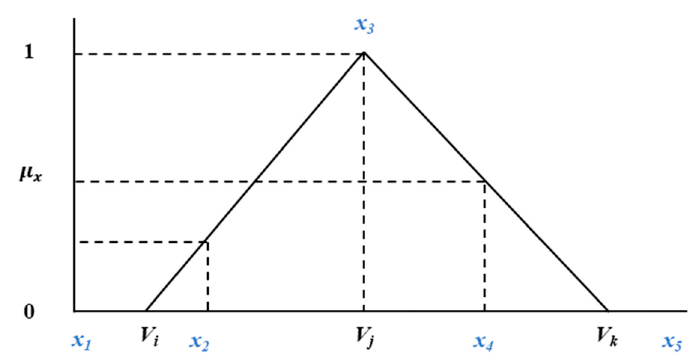
Figure 2. Membership functions calculation procedure for di ff erent positions of